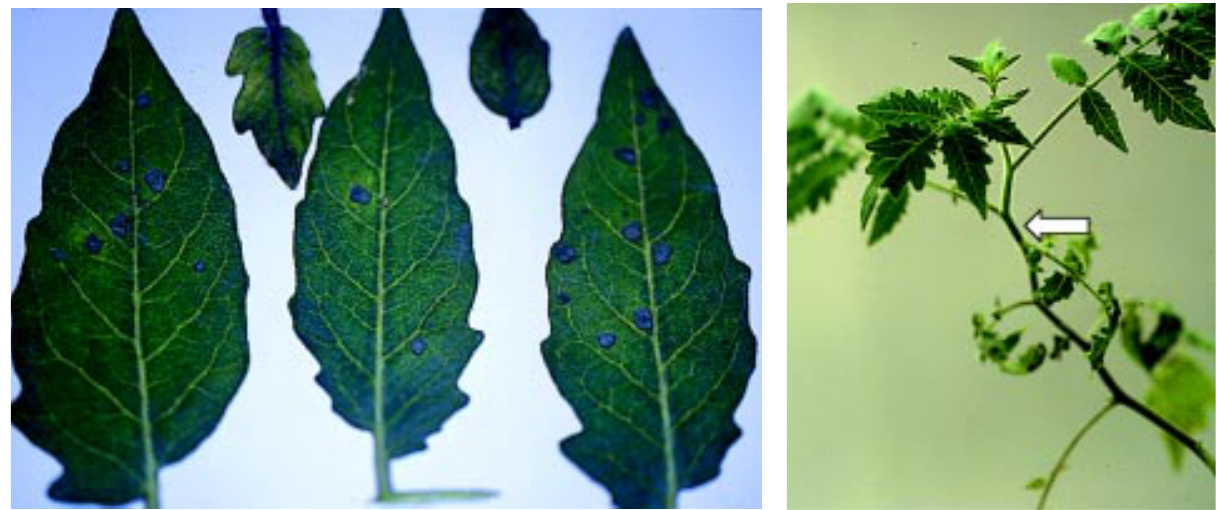
Fig. 3. Local hypersensitive lesions in leaves of accession PI-126944 from Lycopersicon peruvianum resistant to TSWV.